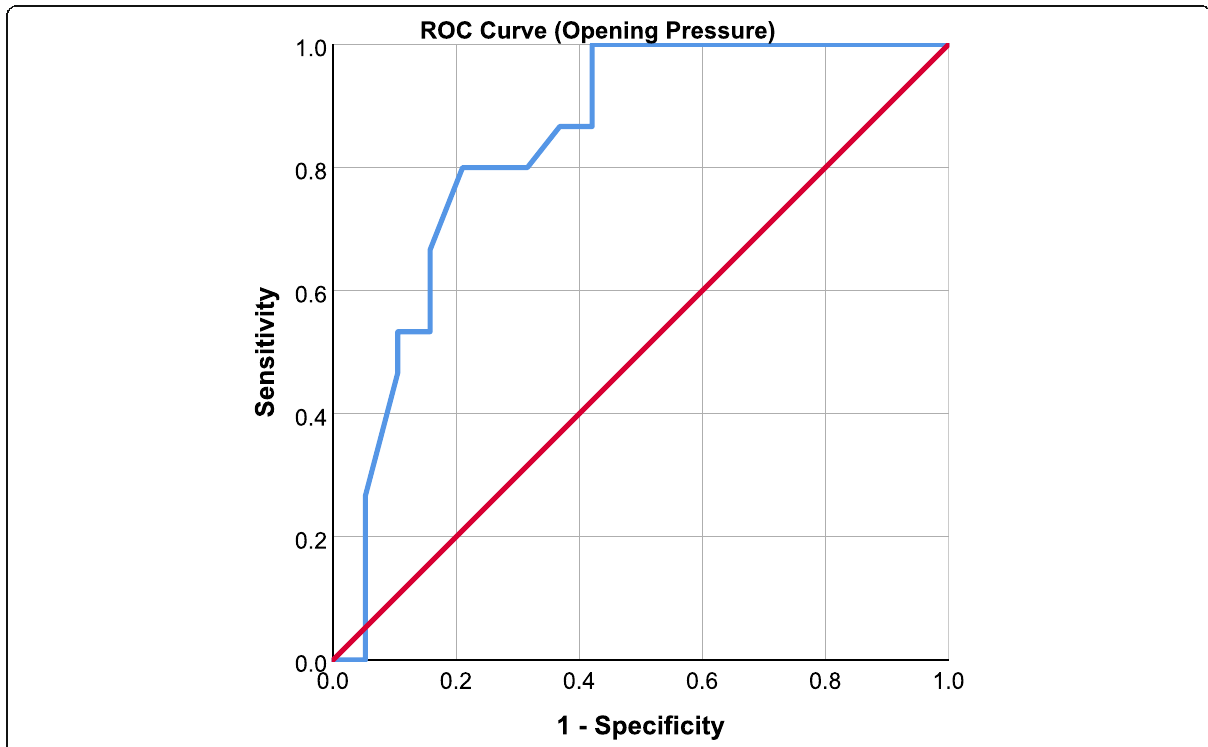
Fig. 5 Cutoff value of OP: OP at cutoff value ≥ 56 cmH2O can discriminate the CI from those without CI (AUC = 0.839, P <